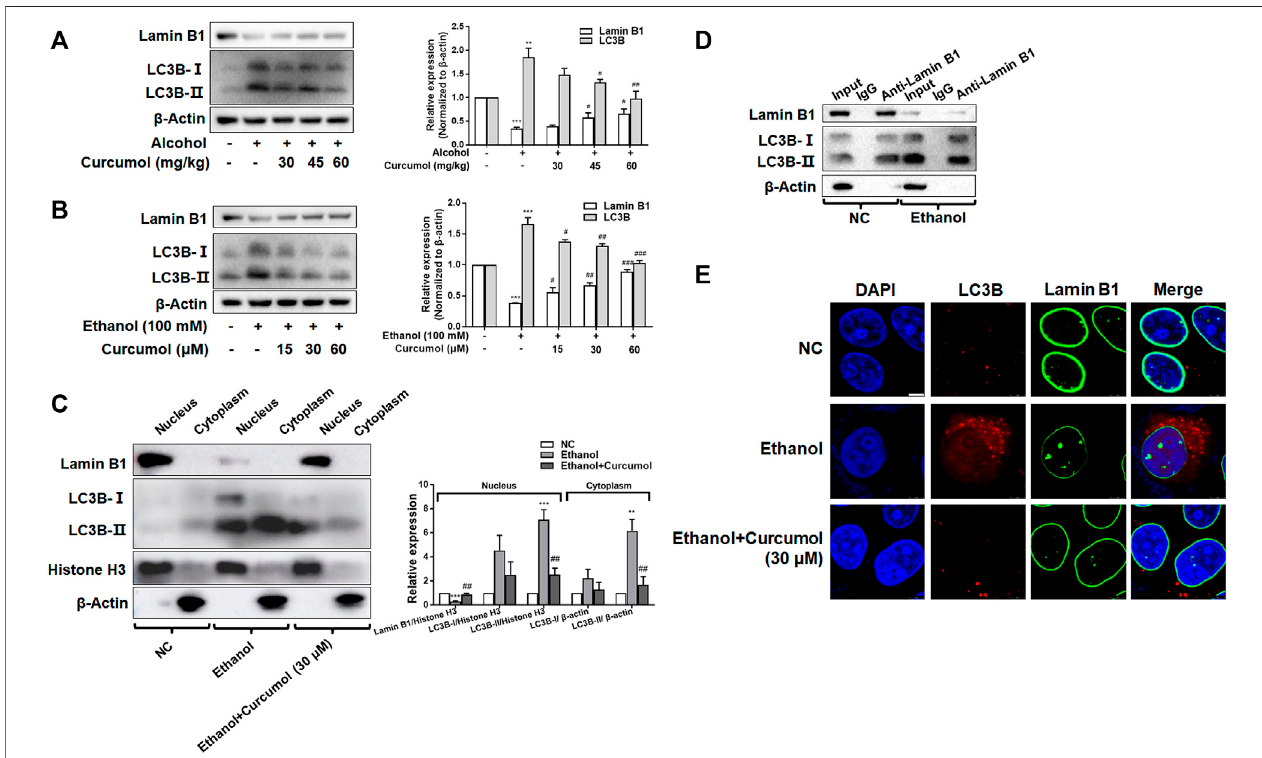
FIGURE5| CurcumolinhibitedLC3BexpressionandblockedLC3B-laminB1interaction. (A) WesternblotanalysesofproteinexpressionofLaminB1andLC3B in vivo , n = 3. Data are represented as mean ± SD. Signi fi cance: ** p < 0.01 and *** p < 0.001 versus control group, # p < 0.05 and ## p < 0.01 versus alcohol group. (B) Western blot analyses of protein expression of Lamin B1 and LC3B in vitro , n = 3. Data are represented as mean ± SD. Signi fi cance: *** p < 0.001 versus control group, # p < 0.05, ## p < 0.01and ### p < 0.001versusethanolgroup. (C) WesternblotanalysesofproteinabundanceofLaminB1andLC3Binthecytoplasmandnucleus, respectively, n =3.Dataarerepresentedasmean±SD.Signi fi cance:** p < 0.01and*** p < 0.001versusnegativecontrolgroup, ## p < 0.01versusethanolgroup. (D) Co- IP analysis of the relevance between Lamin B1 and LC3B. (E) Immuno fl uorescence staining analysis of the localization of Lamin B1 and LC3B in LO2 cells, n = 3. Scare bar, 7.5 μ